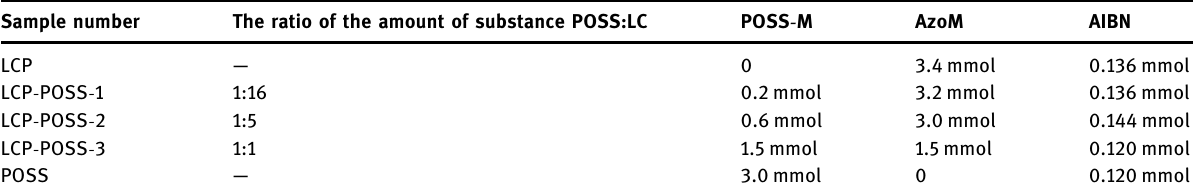
Table 1: Synthesis of LCP - POSS with di ff erent proportions Sample number